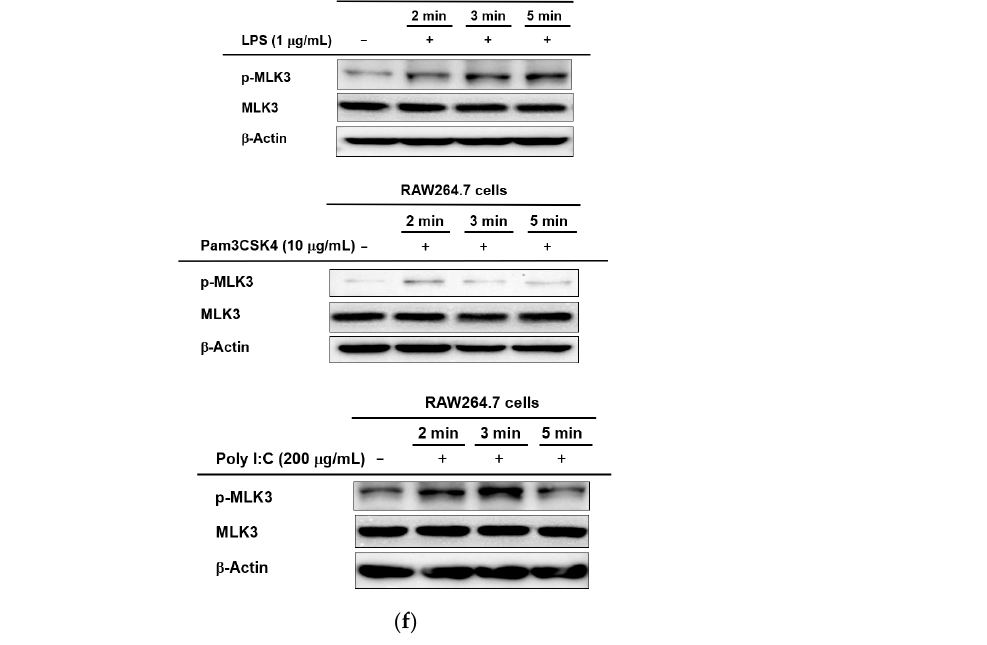
Figure 3. MLK3 is phosphorylated in activated RAW264.7 cells during exposure to LPS, Pam3CSK, and poly(I:C). ( a – e ) The mRNA expression levels of MLK3 and inflammatory genes (COX-2, IL-1 β , IL-6, and TNF- α ) were determined by real-time PCR from RAW264.7 cells stimulated with LPS. ( f ). The phospho- and total forms of MLK3 were detected in whole cell lysates of RAW264.7 cells stimulated with LPS, Pam3CSK, and poly(I:C) by immunoblotting analysis. Results ( a – e ) are expressed as mean ± SD. # p < 0.05 and ## p < 0.01 compared to the normal group (no treatment).